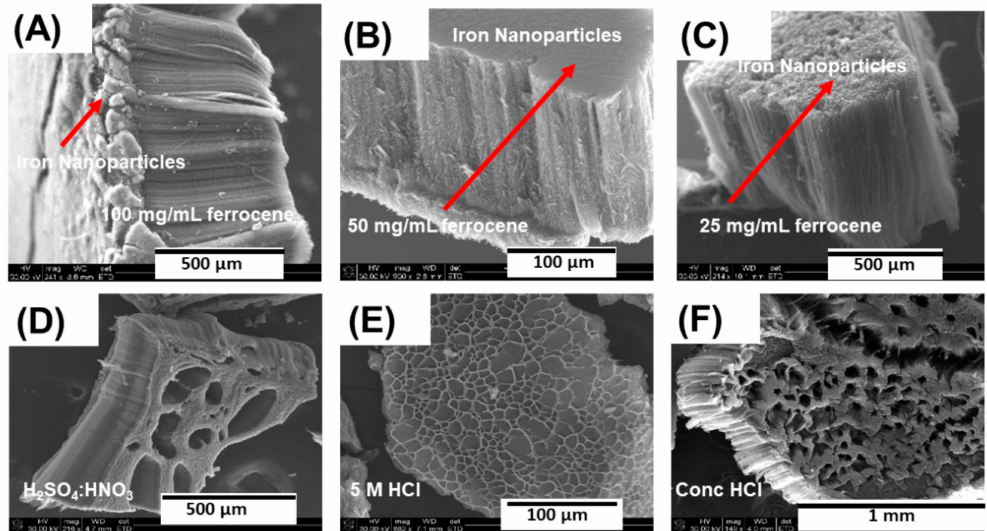
Figure 2. MWCNTs at various catalyst concentrations and purified with different acids. MWCNTs synthesised in 100 mg/mL ferrocene ( A ); MWCNTs prepared in 50 mg/mL ferrocene ( B ); MWCNTs when 25 mg/mL ferrocene was used ( C ). MWCNTs treated with different acids namely concentrated H 2 SO 4 :HNO 3 (3:1) ( D ); 5 M HCl ( E ) and concentrated HCl ( F